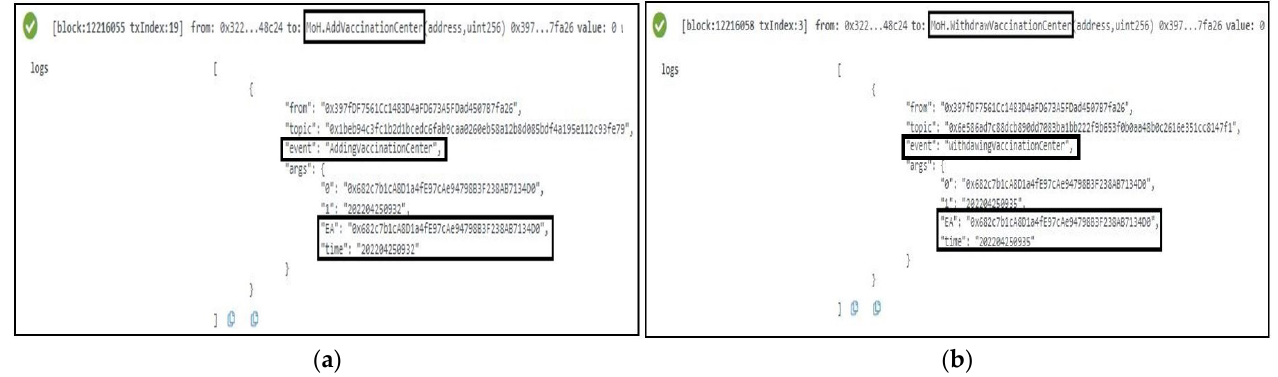
Figure 7. Successful deployment of MoH Smart Contract: ( a ) the addition of the vaccination center is completed; ( b ) withdrawal of a vaccination center is performed.